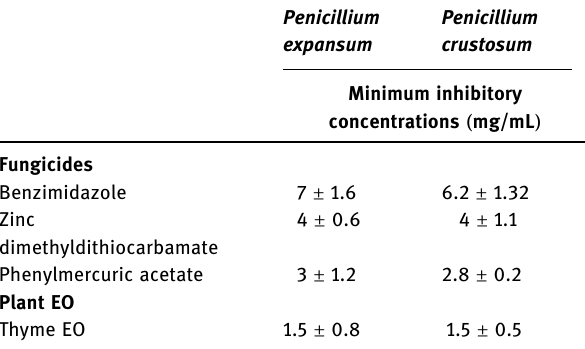
Table 6: Comparative e ffi cacy of the thyme EO with some prevalent synthetic fungicides, ± standard deviation calculated by number of readings = 6